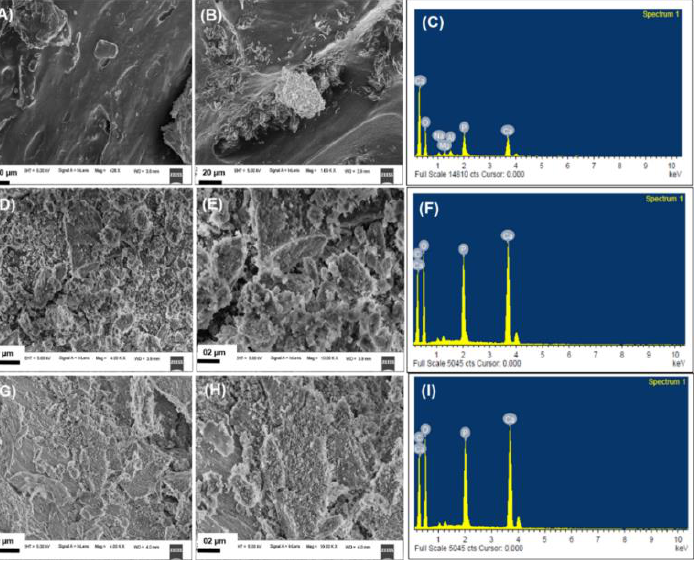
Figure 5. FE-SEM-EDX images ( A and B ) of raw fishbone, images ( D and E ) for alkali-treated nano HA, images ( G and H ) for thermally calcined nano HA, and images ( C , F and I ) EDX images of raw fishbone, alkali-treated nano HA and thermally calcined nano HA, respectively.